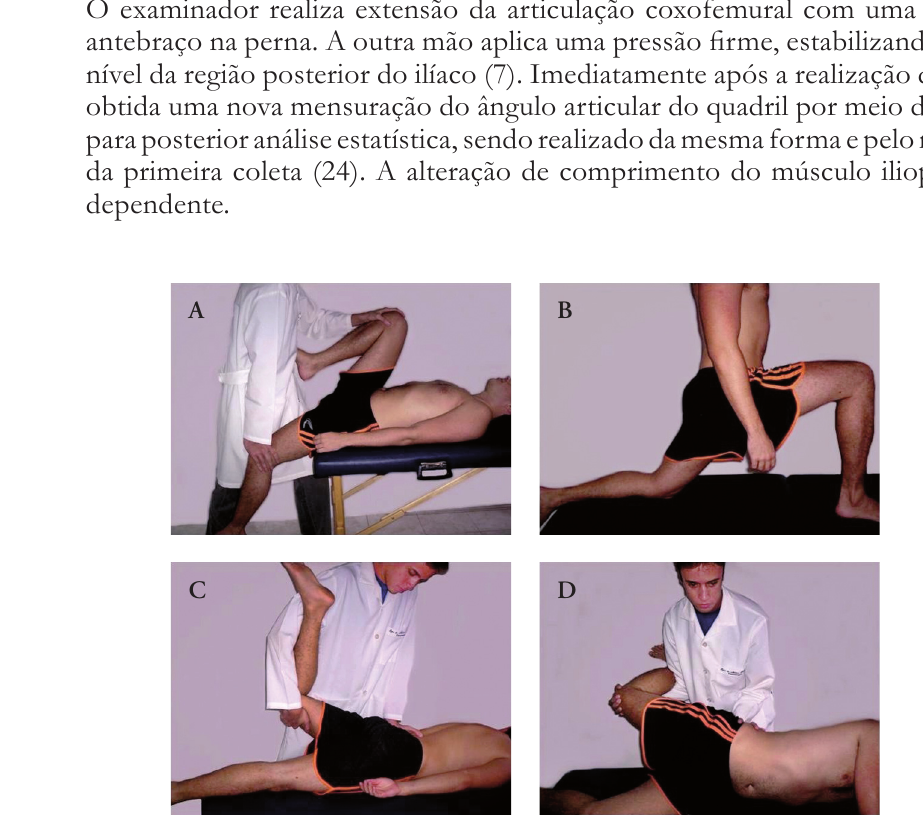
Figura 1 - Posições para alongamento: A = decúbito dorsal; B = semi- fl exão de joelhos. C = decúbito ventral; D = decúbito lateral